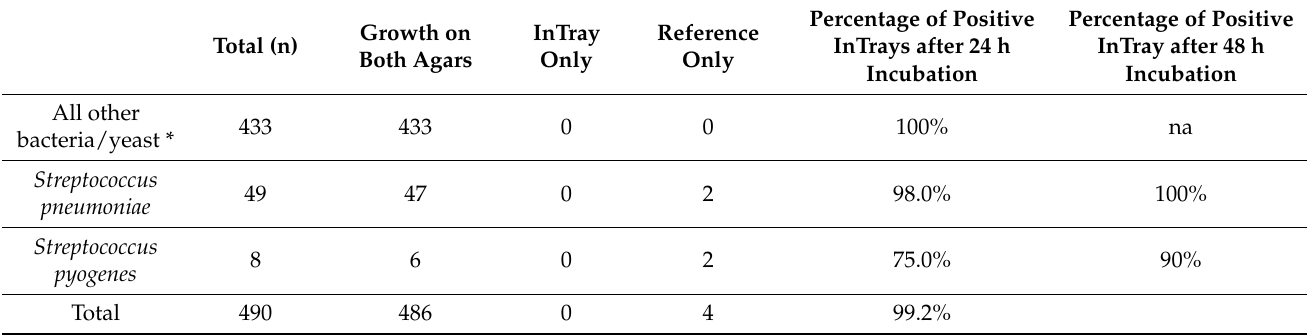
Table 3. Results of the reference validation study expressed in terms of the percentage of positivity at 24 h and 48 h of incubation.